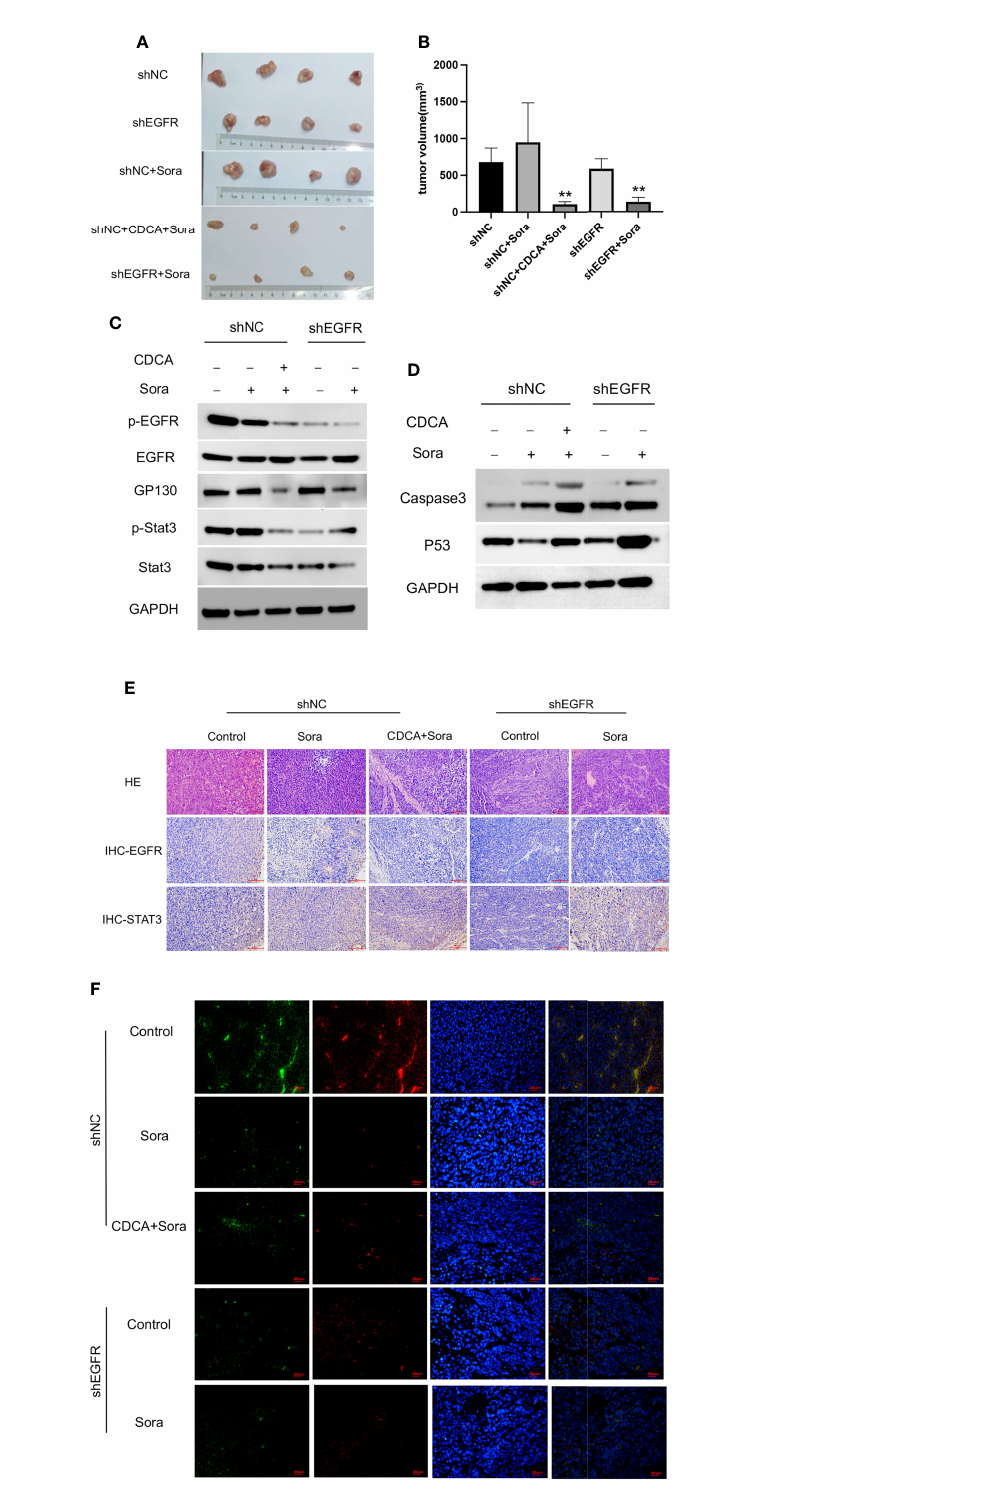
FIGURE 7 | In vivo validation of CDCA-mediated inhibition of EGFR. The knockdown EGFR cells were transplanted into nude mice, and the rest of the operation was performed as in previous in vivo experiments. (A) Transplanted tumors. (B) Transplanted tumor volumes. ** P < 0.01 vs. shNC-Sora. (C) EGFR and Stat3 protein and phosphorylation levels. (D) Caspase 3 and p53 protein expression. (E) HE and immunohistochemical staining of tumor tissues (20x). (F) Immuno fl uorescence staining of tumor tissues